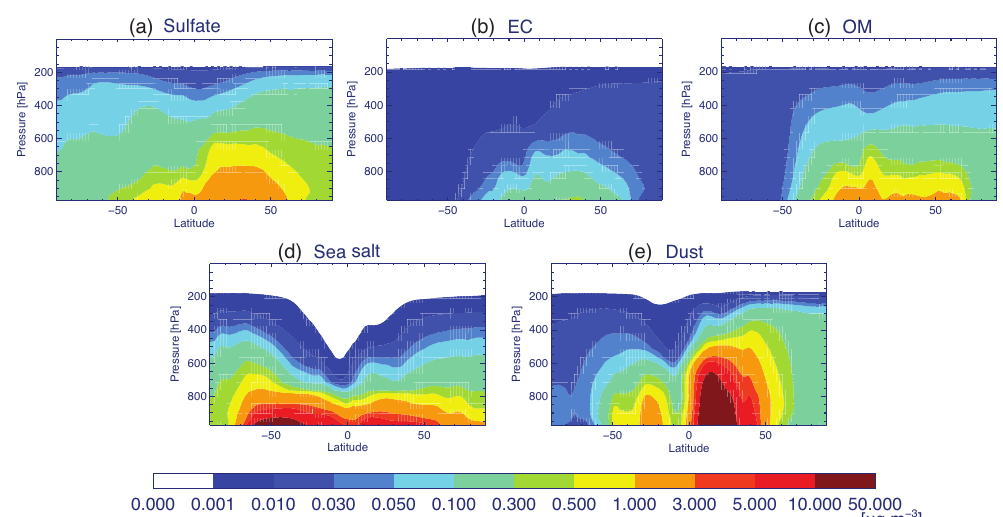
Figure 7. Annually and zonally averaged concentrations of (a) sulfate, (b) EC, (c) OM, (d) sea salt, and (e) dust in the ModelE2-TOMAS BASE run. Units are µgm − 3 .